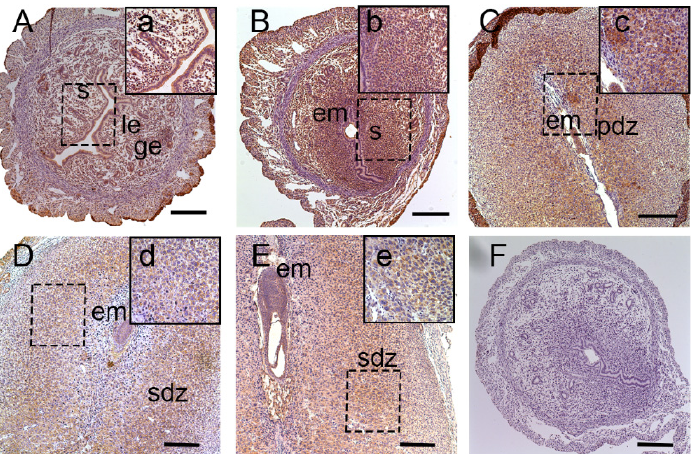
Figure 1. Immunostaining of lat1 in mouse uterus from D4 to D8 of pregnancy. Original magnification immunostainingof lat1 in mouse uterus from D4 to D8 of pregnancy on Days: 4 ( A ); 5 ( B ); 6 ( C ); 7 ( D ); and 8 ( E ) of pregnancy, 100 times magnification. Bar = 25 µ m. a–e: inserts shows 400 times magnification; and ( F ): Negative control (IS: implantation sites, IIS: inter-implantation sites, em: embryo, ge: glandular epithelium, le: luminal epithelium, s: stromal, pdz: primary decidual zone, sdz: secondary decidual zone). There were 15 mice sacrificed on every day of pregnancy.